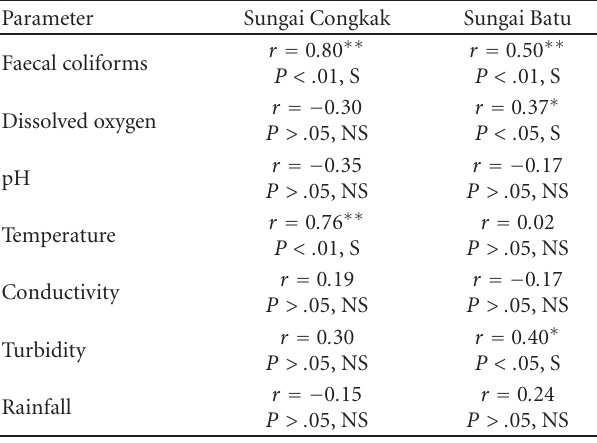
Table 4: Correlations between Blastocystis and faecal coliforms, physical parameters, and rainfall in the two